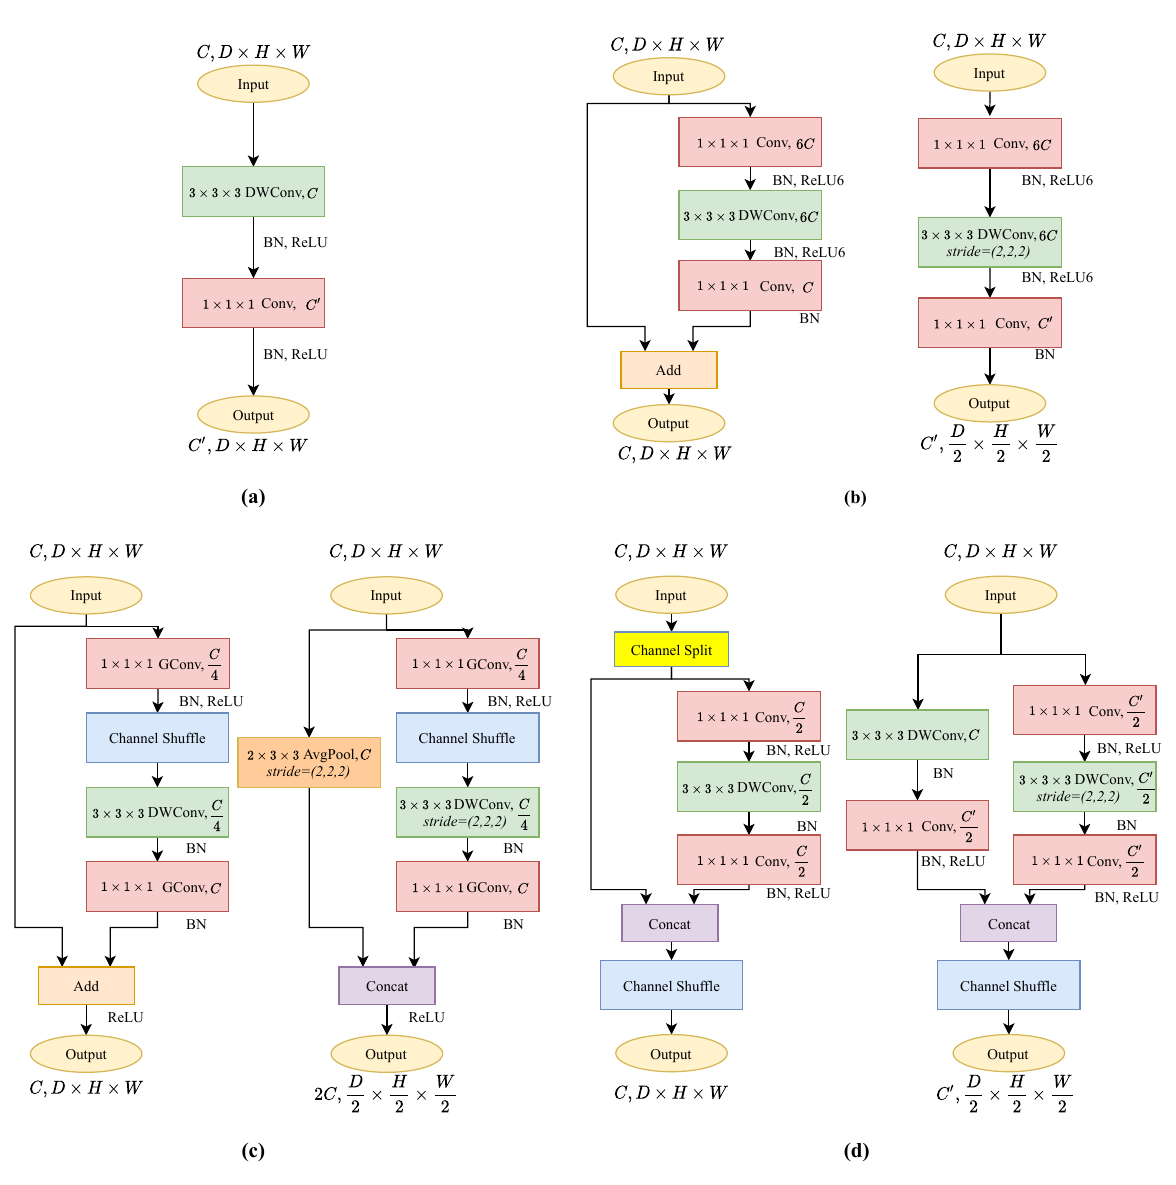
Figure 2. The architecture of 3D lightweight CNN kernels. ( a ) 3D MobileNetV1. ( b ) 3D MobileNetV2. ( c ) 3D ShuffleNetV1. ( d ) 3D ShuffleNetV2. Each module has the same effect as a 3 × 3 × 3 convolution